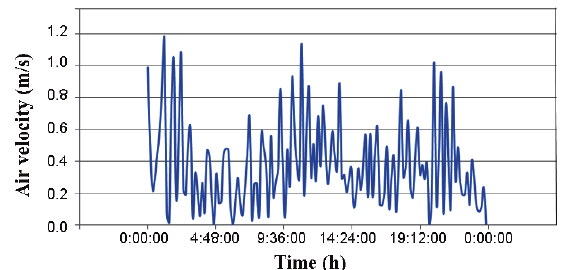
Fig. 7. Measured air velocity in the inlet opening (Zender- Swiercz, Piotrowski 2010) (winter)